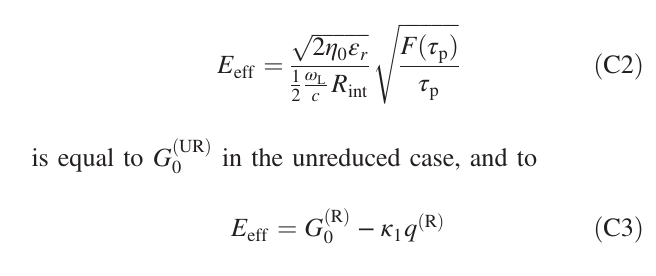
2 μ m, ε 2 . 1 and β 1 : r ¼ L ¼ ph ¼ 0 . 5 λ . int ¼ L